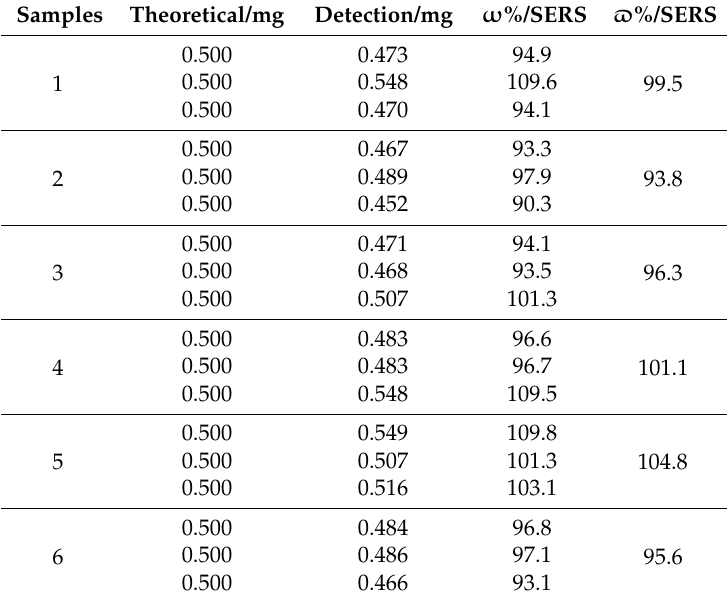
Table 2. Detection results of six negative real samples with SH